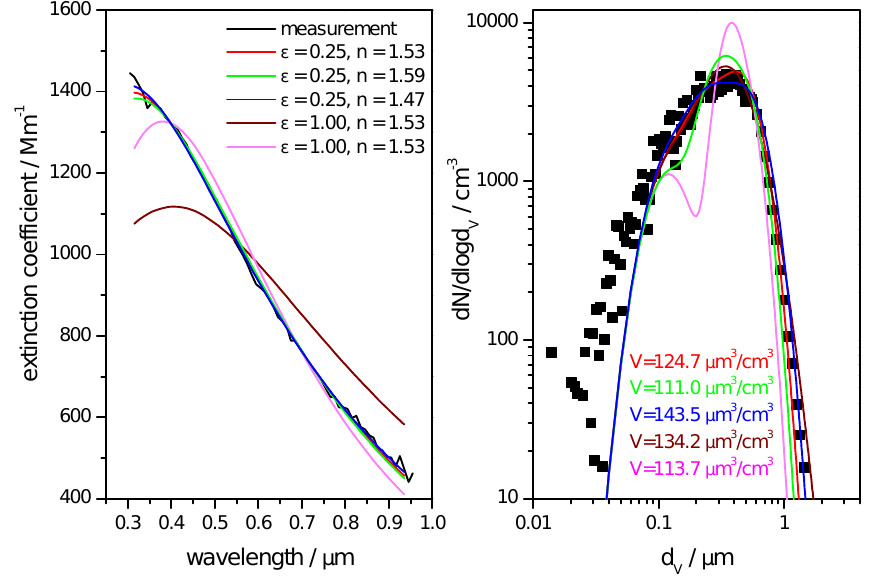
Fig. 8. Measured extinction spectrum (left panel, black line) and number size distribution (right panel, black squares) of dispersed dust particles from the SAMUM B3 soil sample (Exp. 8). The recordings are compared to best fit results for different assumptions on the particle shape and the real part of the complex refractive index (coloured lines), see text for details. The total volume concentrations, V , of the dust particle loading, as calculated from the various fitted number size distributions, are indicated in the right